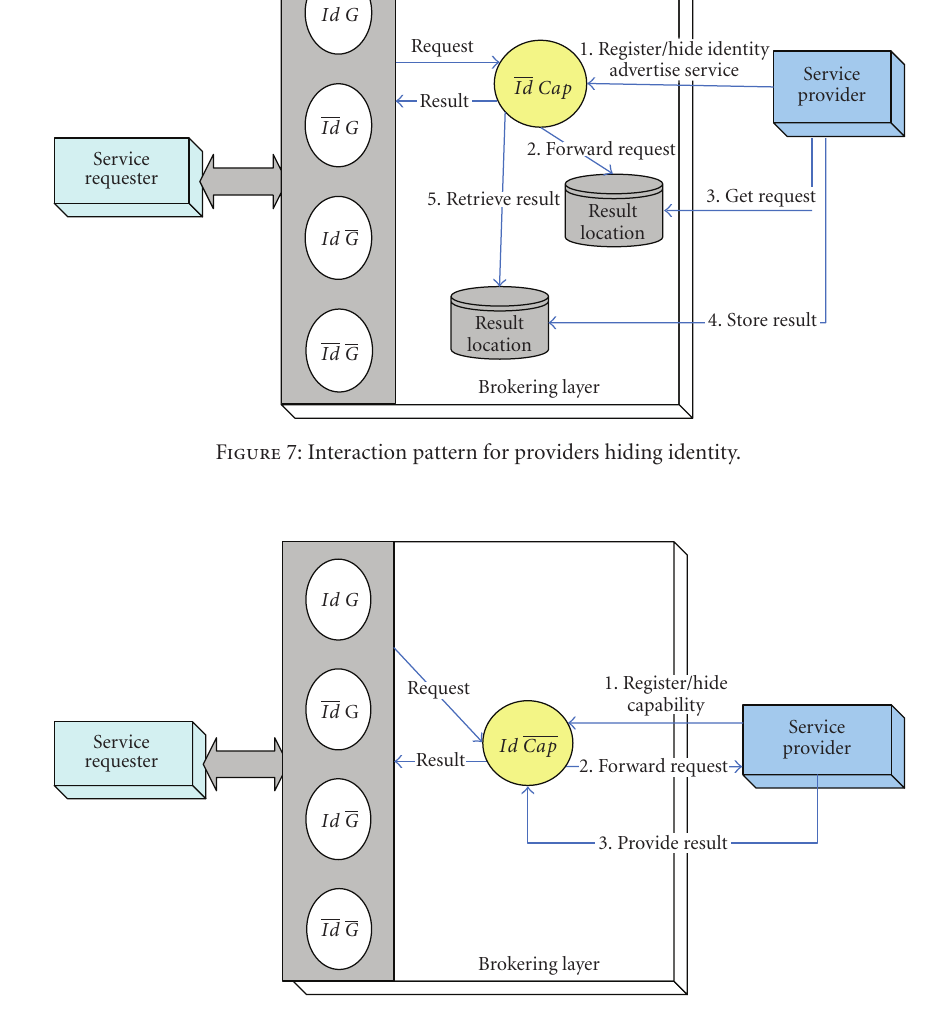
Figure 8: Interaction pattern for provider hiding